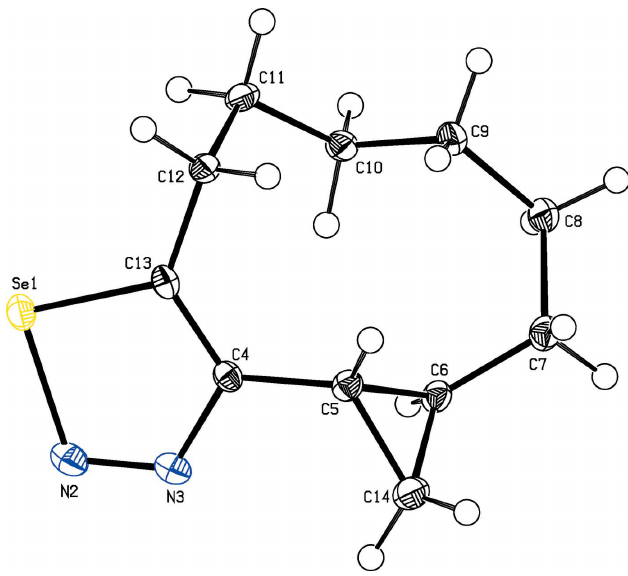
Figure 1 Perspective view of the title compound with displacement ellipsoids drawn at the 50% probability level.